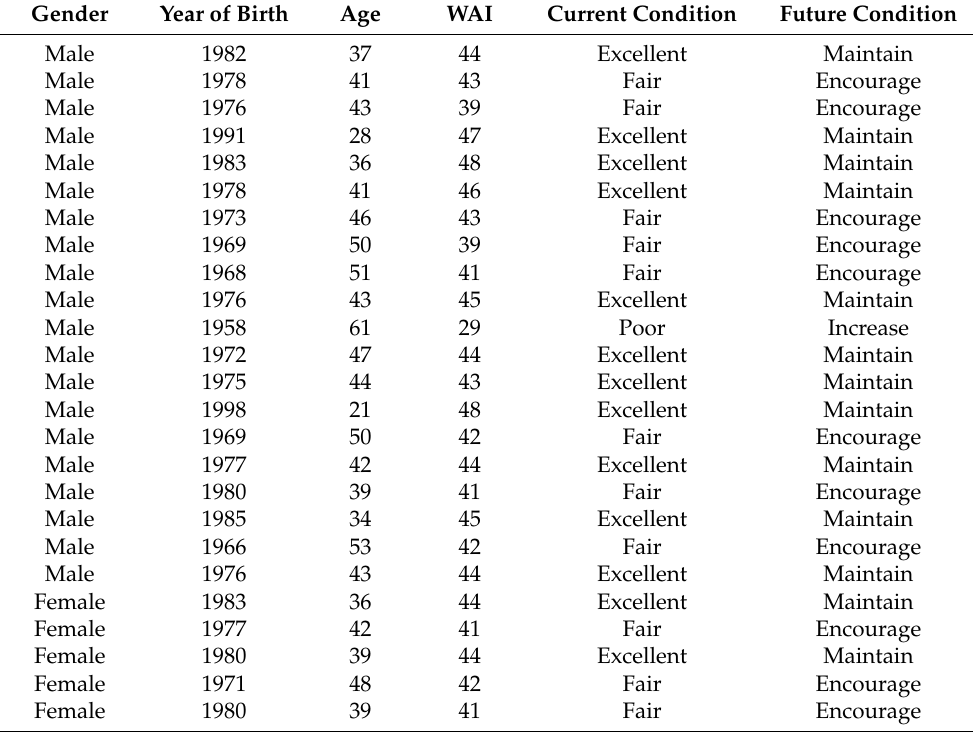
Table 2. Values obtained upon applying Work Ability Index.